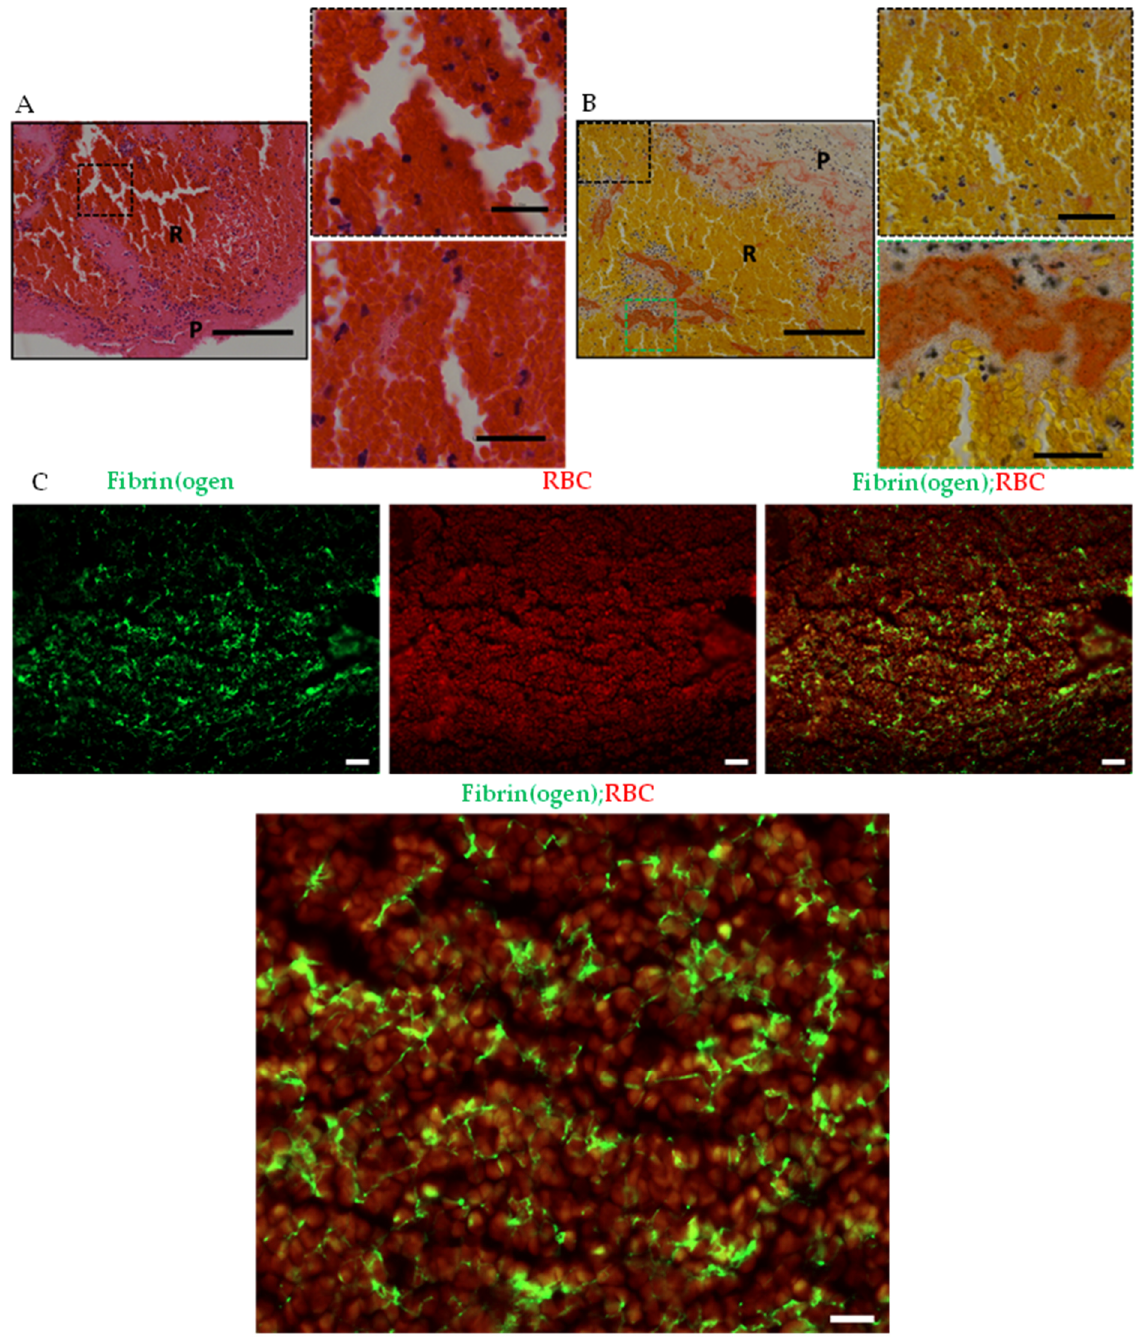
Figure 4. Densely packed RBC in fibrin meshwork present in RBC-rich areas (R). ( A ) Hematoxylin and Eosin (H&E) staining of stroke thrombi at low (left panel) and high (right panels) magnifications show a high abundance of RBC (appearing red) surrounded by fibrin (pink) with sparsely populated or no nucleated cells (blue) in RBC-rich areas. Scale bars: 200 µ m, left panel; 25 µ m, right panels ( B ) Martius Scarlet Blue (MSB) staining of stroke thrombi at low (left panel) and high (right panels) magnifications show densely populated RBCs (appearing yellow) in thin Fibrin network (appearing red). Sparsely populated or no nucleated cells (blue) are seen in the RBC-rich areas. Scale bars: 200 µ m, left panel; 25 µ m, right panels ( C ). Immunofluorescence staining of stroke thrombi. Fibrinogen-specific antibody was used to visualize fibrin (first panel, green) and RBCs by autofluorescence (mid-panel, red). Fibrin is interwoven in densely populated RBCs (right panel, low magnification; and lower panel, high magnification). Scale bars are 30 µ m. P: platelet-rich area; R: RBC-rich